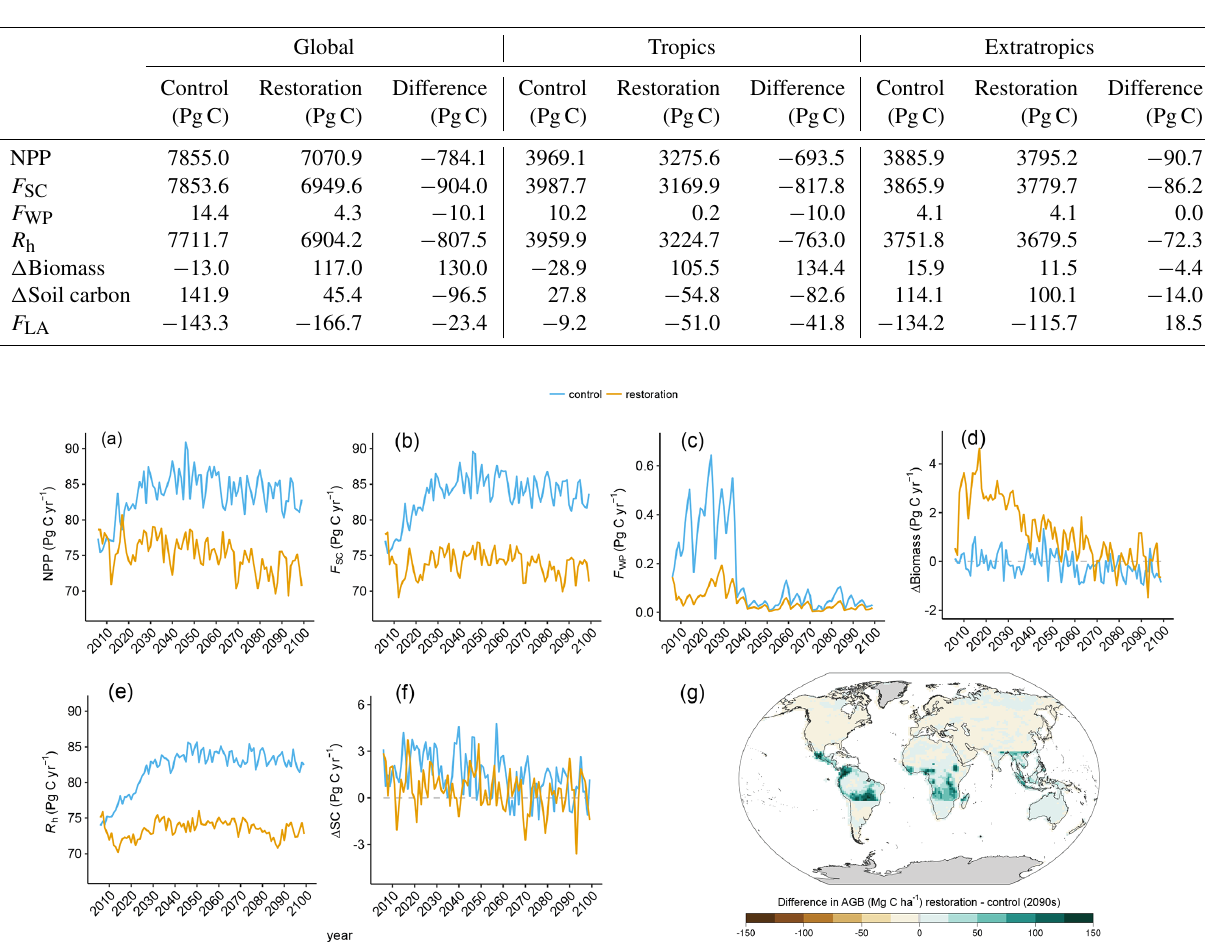
Table 1. Cumulative terrestrial carbon fluxes for NPP, litterfall ( F SC ), flux to the wood product pools ( F WP ), soil respiration ( R h ), net change in living biomass ( NPP − F SC − F WP ) , net change soil carbon ( F SC − R h ), and the net land-to-atmosphere carbon flux ( F LA ) over the period 2006–2100CE in the control and restoration simulations, as well as their difference. Global, tropical, and extratropical fluxes are presented. Negative F LA values indicate a net terrestrial sink. Values may not completely add up due to rounding.